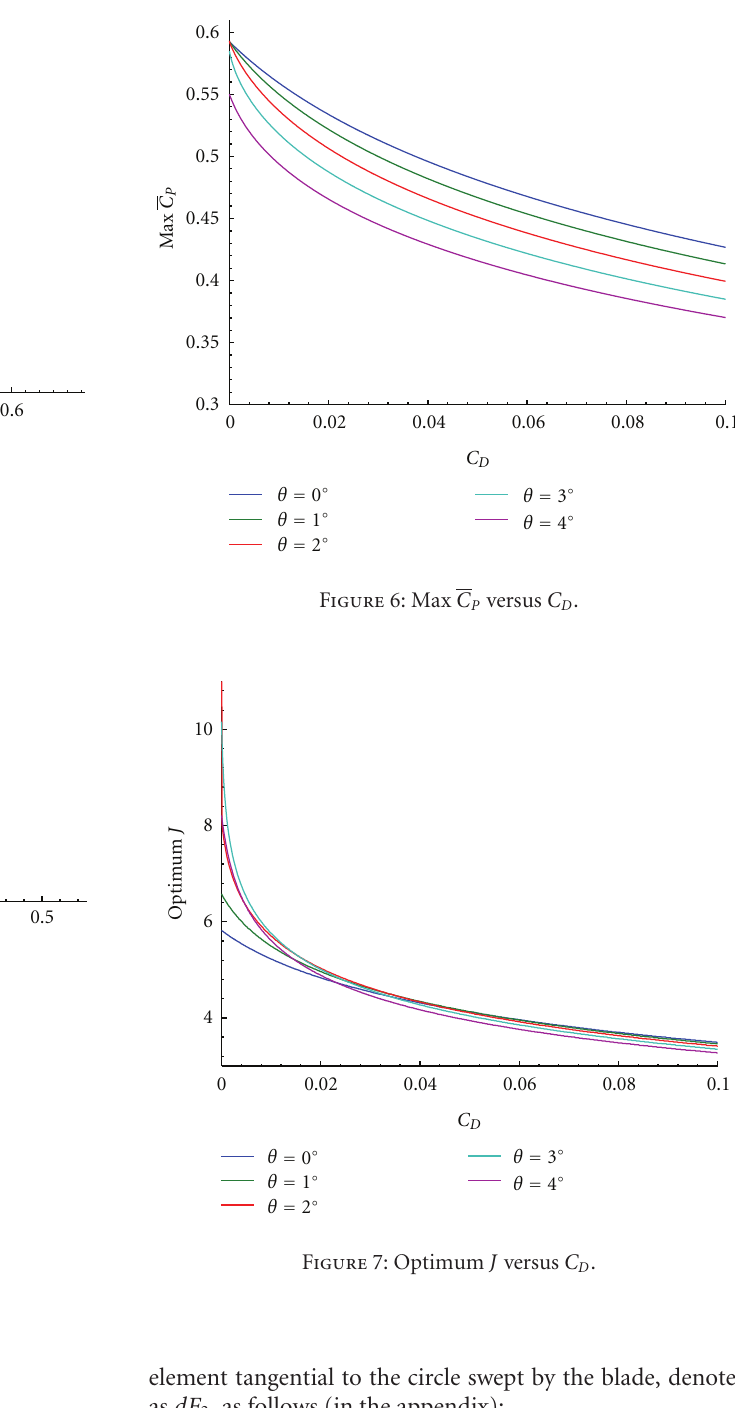
Figure 7: Optimum J versus C D